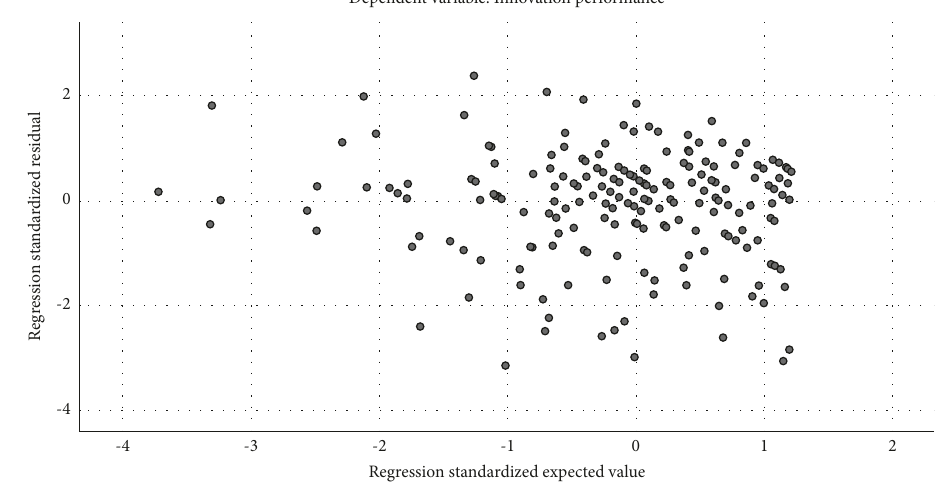
Figure 3: Residual scatter plot of the regression